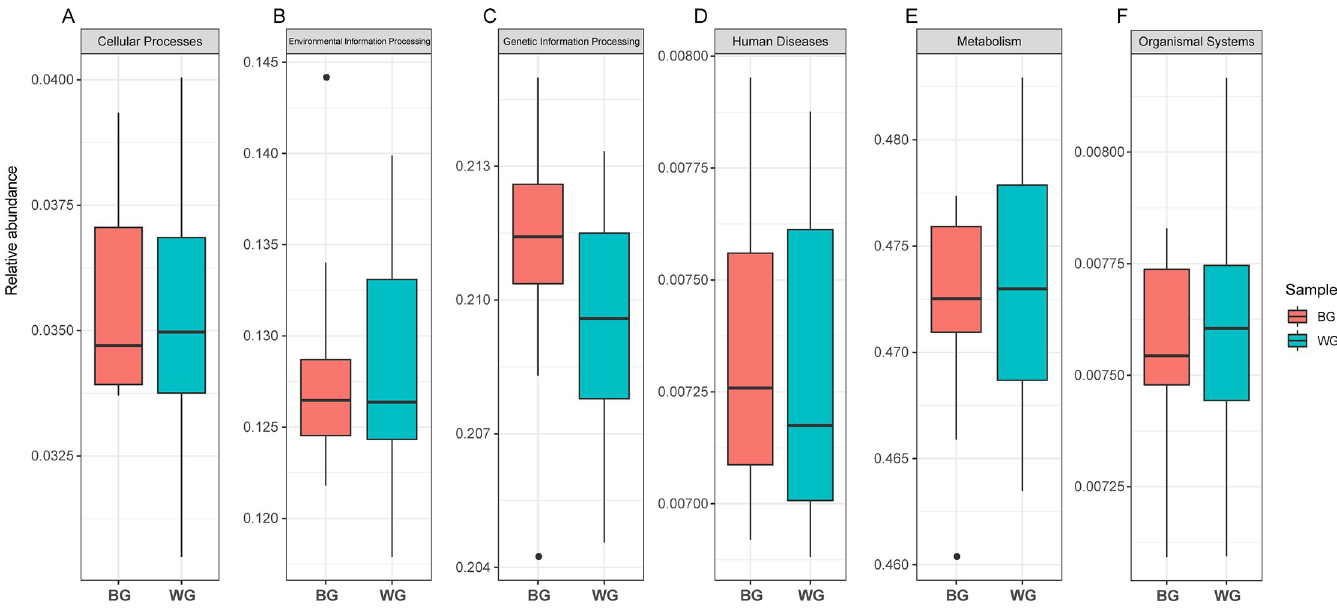
BG and WG. We also found that only Bacteroides overlapped with the core gut microbiota and enriched in the WG group. The comparison of major metabolic pathways between samples PICRUSt (v 1.0) was used to predict functional features based on the V3-V4 regions of 16S rRNA gene sequencing data to determine the potential role of the gut microbiota present in goats. In the primary metabolic pathways, there were no significant differences between BG and WG (Fig 5) and the metabolism pathway had a high abundance above all. The metabolic secondary pathways with relative content greater than 0.01% were listed (Fig 6). Membrane transport, carbohydrate metabolism, replication and repair and amino acid metabolism were the major metabolic secondary pathways and had high abundance in the BG and WG. The two-tailed t test showed that the microbial pathways of metabolism, enzyme families and poorly characterized had significant differences between the BG and WG groups, but due to the low content, it is not obvious in the figure. Furthermore, the tertiary metabolic pathways were predicted, in which pyruvate metabolism pathway had higher abundance in the BG group, to the contrary, peptidases pathway had higher abundance in the WG (S1 Table). Correlation between microbiota and microbial pathways We calculated the correlation between the core microbiota and the core metabolic pathways and drew the network (Fig 7), in which the blue circle represented the genera and the pink